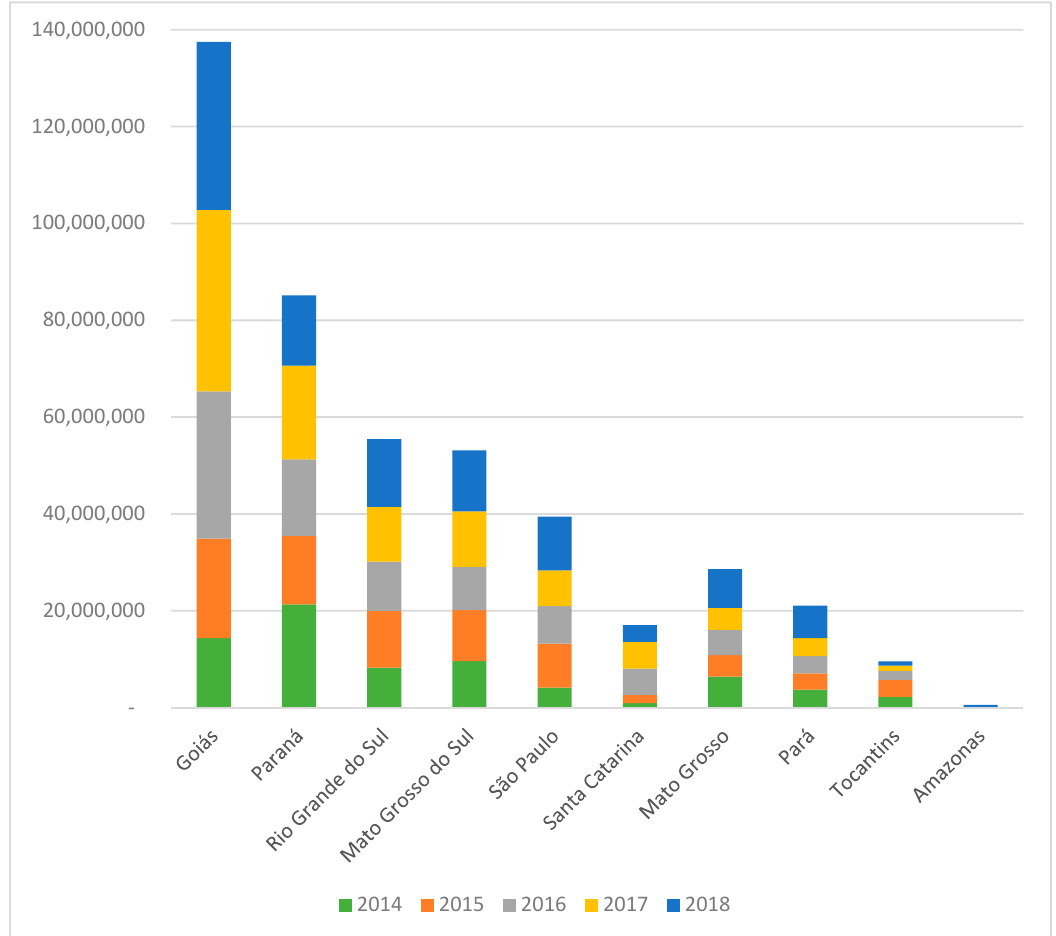
Figure 4. Top 10 Brazilian states exporting to Italy in the period 2014–2018; net weight in kg [48]. Table 1. Wet-blue exports from the Par á state in 2018, in net value (USD), net weight (kg) and percentages relative to the grand total.